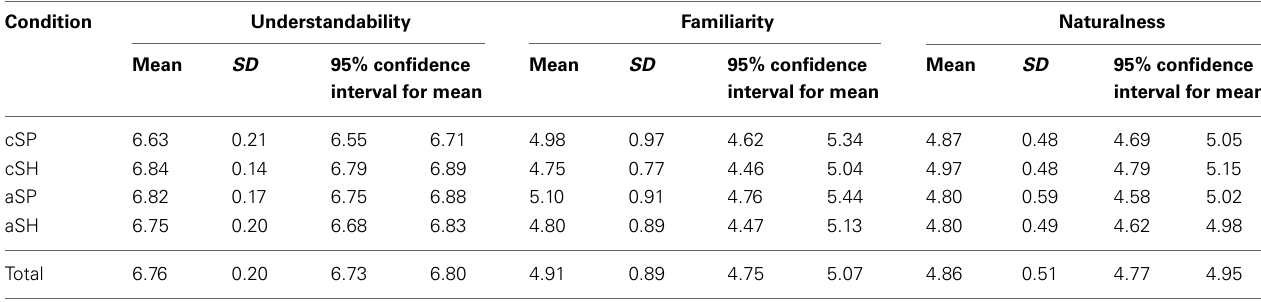
Table 2 | Control variables: understandability, familiarity and naturalness. Condition